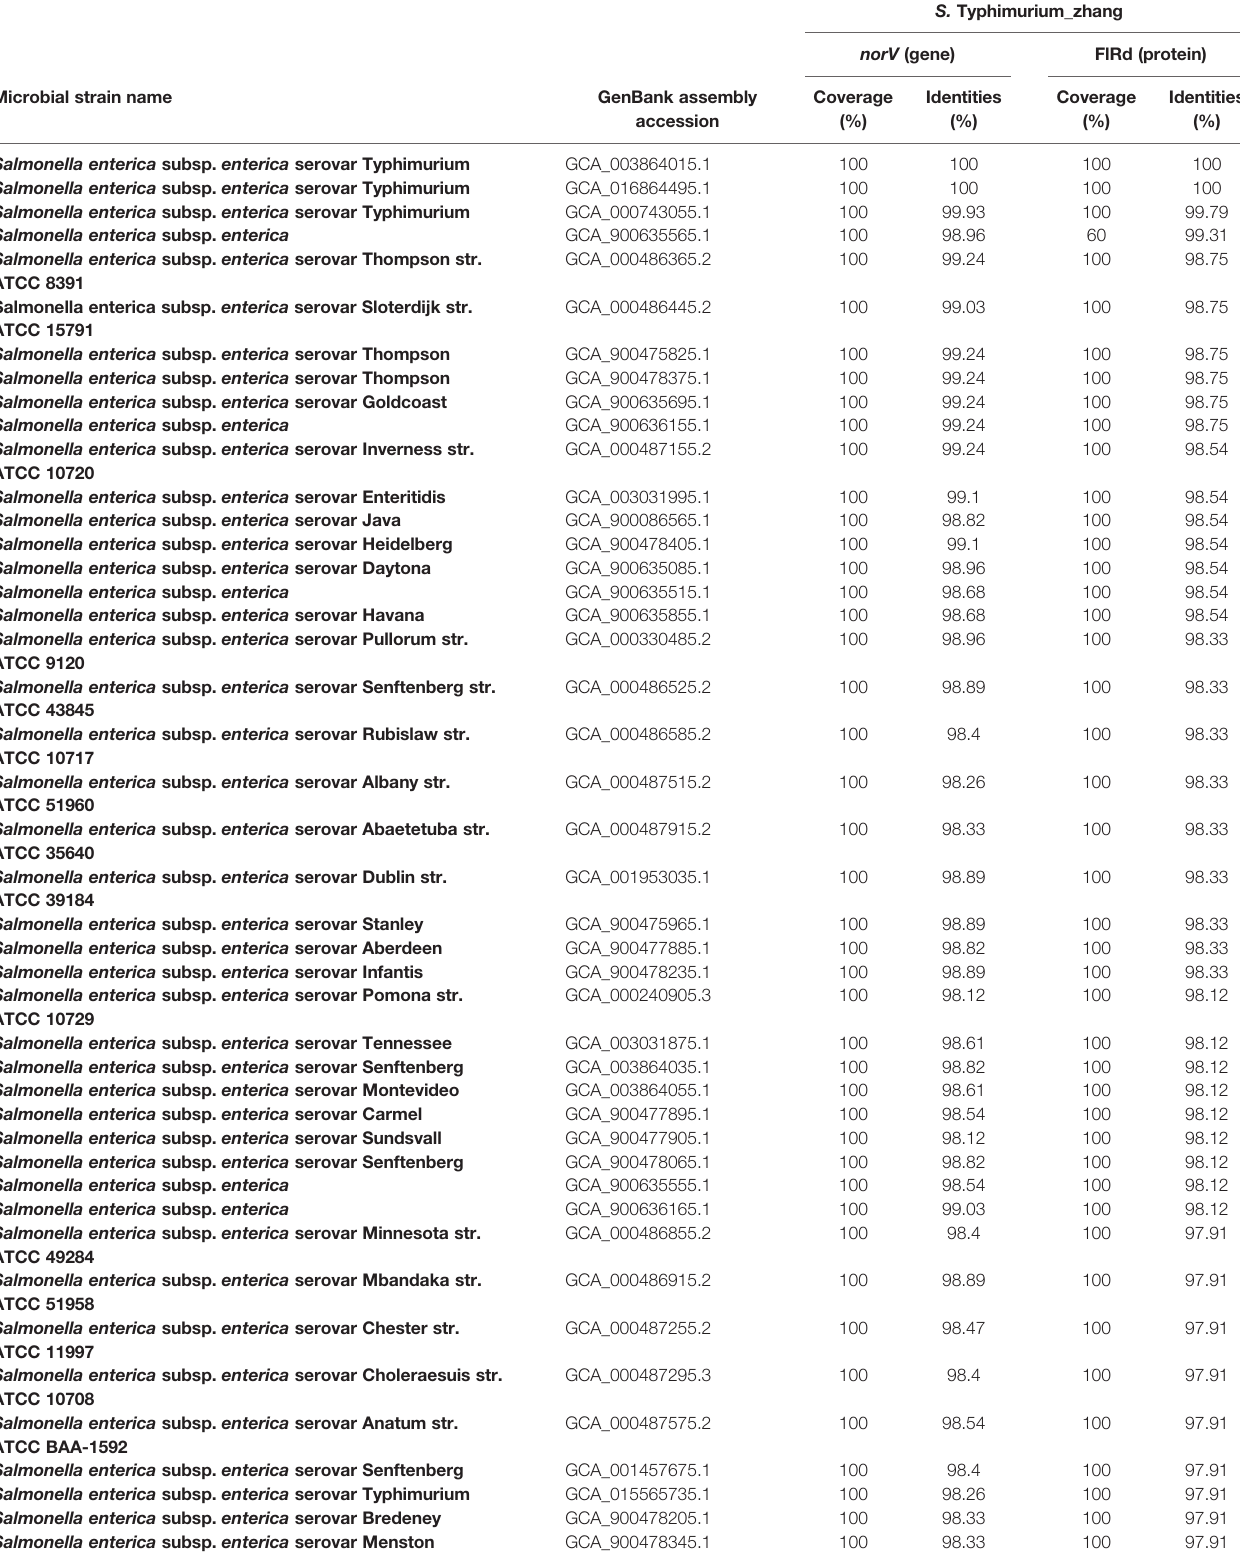
TABLE 2 | Identity of norV and FlRd on 73 S. enterica strains based on